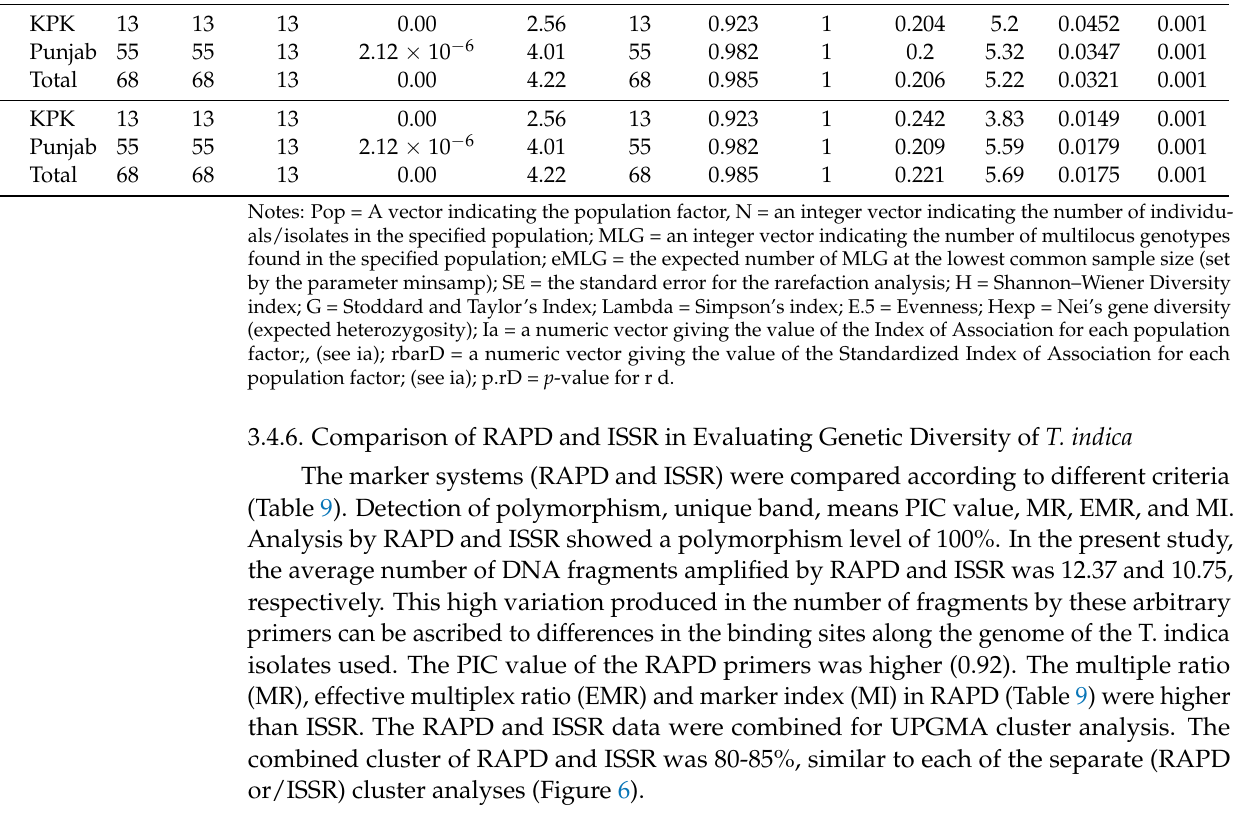
Table 9. Comparison of RAPD and ISSR marker in evaluating genetic diversity of T. indica